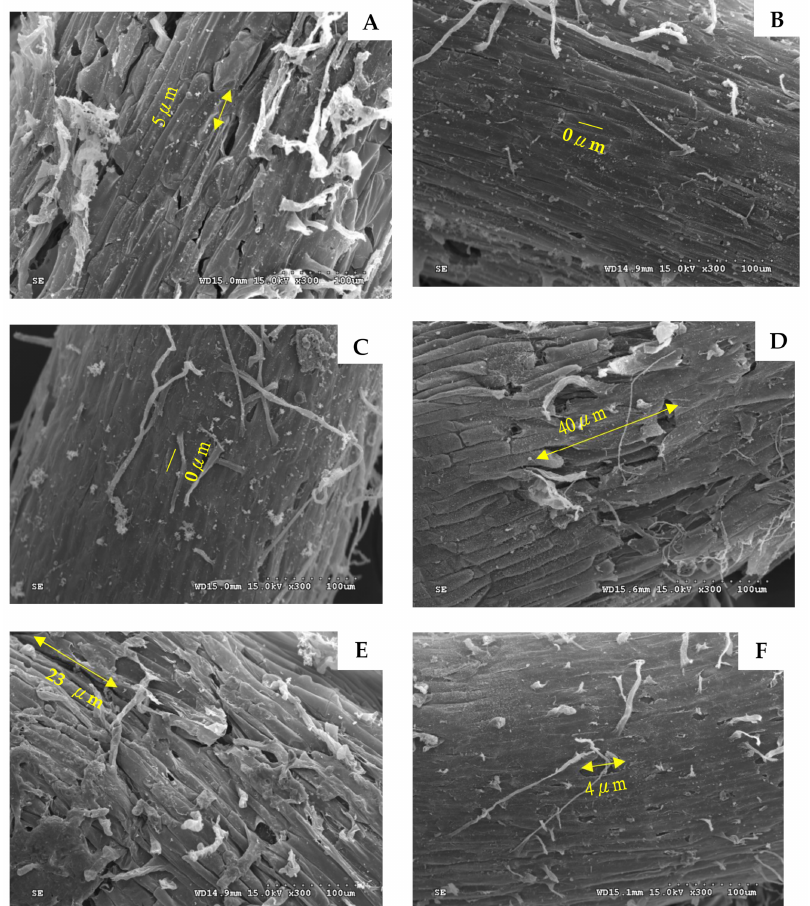
Figure 1. SEM images of lettuce root apices with different salt and sulfur fertilizer treatments. ( A ) S 0 H 0 , ( B ) S 0 H 1.5 , ( C ) S 0 H 3.0 , ( D ) S 40 H 0 , ( E ) S 40 H 1.5 , ( F ) S 40 H 3.0 . S 0 and S 40 represent 0 and 40 mM NaCl, respectively. H 0 , H 1.5 , and H 3.0 represent 0, 1.5, and 3.0 g L − 1 HSLF fertilizer,